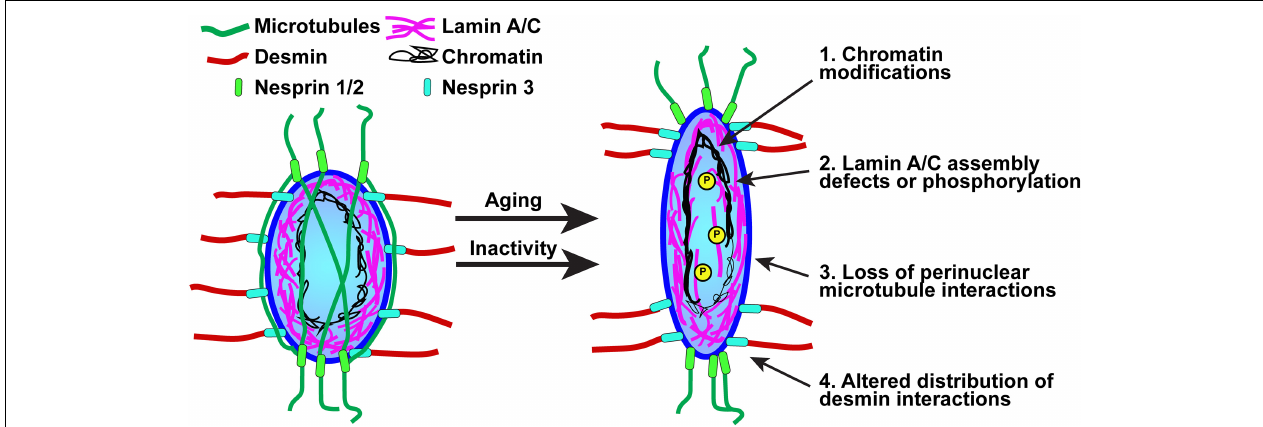
FIGURE 2 | Proposed mechanisms for nuclear-intrinsic and -extrinsic changes that could alter nuclear morphology in response to inactivity or aging. Nuclear stiffness is determined by both A-type lamins expression/assembly and chromatin modifications, specifically the amount of heterochromatin. Phosphorylation of A-type lamins leads to a nucleoplasmic localization and a decrease in nuclear stiffness. Nuclear morphology is also influenced by cytoskeletal forces acting through the LINC complex. Microtubules form a cage-like structure around the nucleus and provide compressive force; thus, elongation could be driven by a decrease in microtubule-nuclear interactions. Loss of desmin or plectin-1 results in more rounded nuclei, suggesting that changes in either the number or arrangement of desmin-nuclear interactions could elicit a change in nuclear